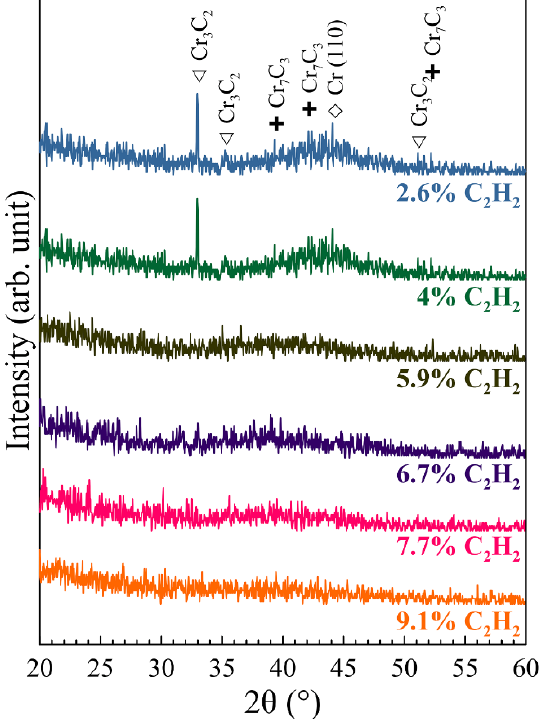
Figure 2. X-ray diffractograms of Cr–C films deposited on Si (100) at 0.8 Pa deposition atmosphere with different C 2 H 2 fractions with applying a substrate bias of −150 V.